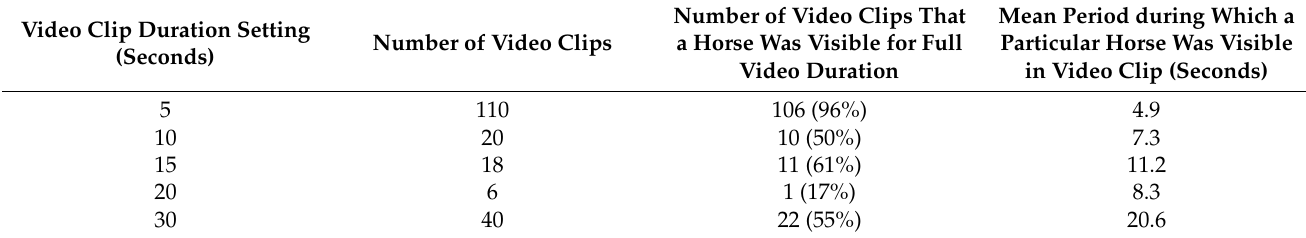
Table 6. Video clip durations and the period during which the horse was visible in the video clip. Mean Period during Which Number of Video Clips That Video Clip Duration Setting Number of Video Clips a Horse Was Visible for Full (Seconds) Video Duration